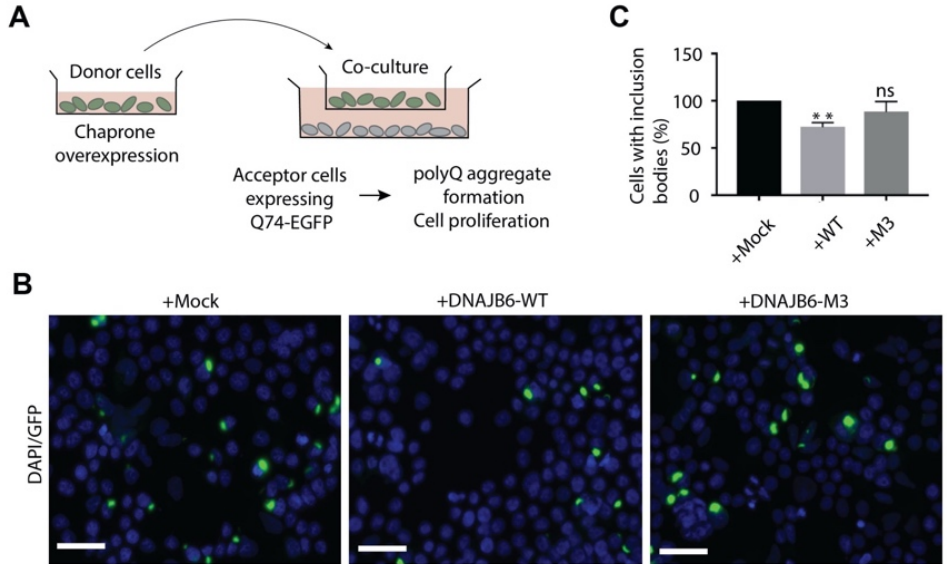
Figure 1. Cell-non-autonomous reduction in polyQ aggregation in Q74-EGFP-expressing HEK293T cells upon co-culture with DNAJB6-WT-expressing HEK293T cells. ( A ) Co-culture assays setup for assessment of overexpression of DNAJB6 on polyQ aggregation in recipient cells. ( B ) Representative fluorescence microscopy images of Q74-GFP expressing recipient cells co-incubated with mock, DNAJB6-WT, or DNAJB6-M3 transfected HEK293T donor cells. Bar: 40 µ m. DAPI: nuclei, GFP: polyQ aggregates. ( C ) Graphical representation of microscopy analysis Q74-GFP aggregates resulted from co-culture experiments (n = 3, number of cells counted >900 per condition, mean ± SEM, ** p < 0.01, ns: not significant).